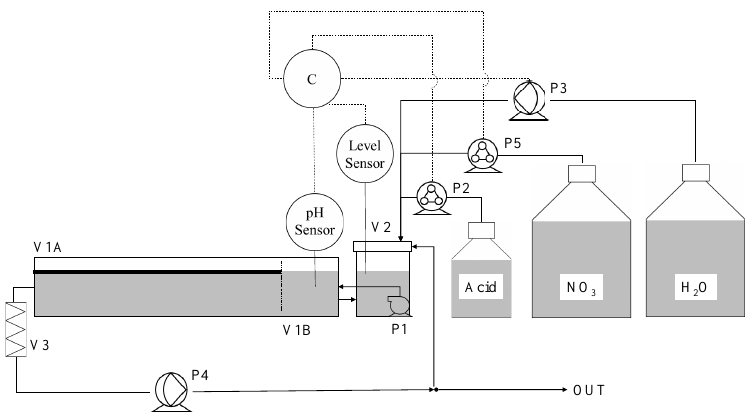
Figure 1. Diagram of phytoremediation tank. P1 is a submersible pump, P2 and P5 are stepper motor peristaltic pumps, P3 and P4 are larger diaphragm pumps. V1 is a 30 L tank: L. minor was grown